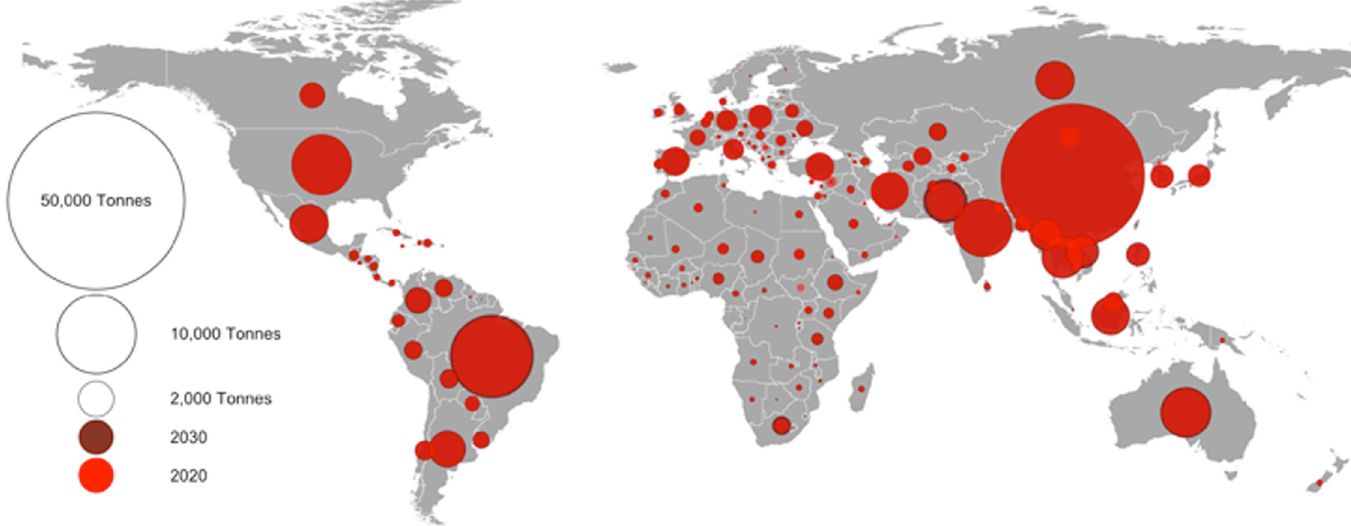
Fig 2. Antimicrobial consumption per country in 2020 and 2030. Circles are proportional to quantity of antimicrobials used. Red circles correspond to the quantity used in 2020, and outer dark red ring corresponds to the projected increase in consumption in 2030. Country boundaries were obtained from GADM (https://gadm.org/